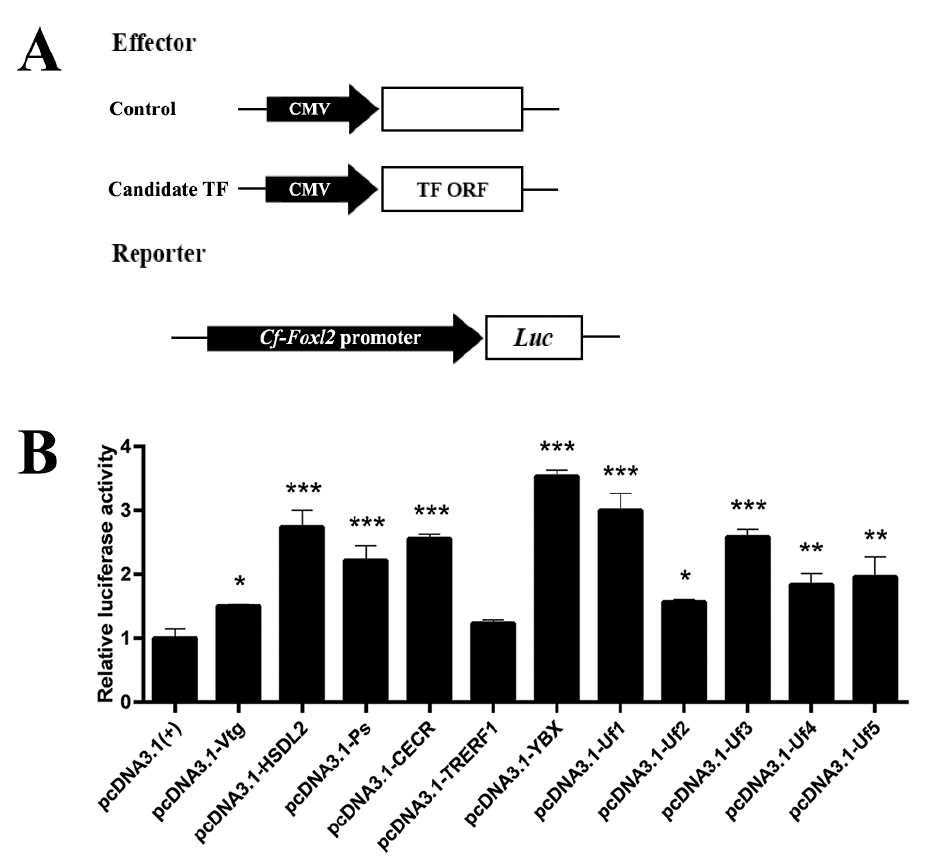
Figure 3. Cf-Foxl2 transcriptional regulation by the candidate factors detected with transient trans- fection. ( A ) Schematic representation of the report vector and effector vector compositions. ( B ) The Cf-Foxl2 transcription regulation in the HEK293T cells transfected transiently with the report and effect vectors. 1: PGL3- Foxl2 - Luc + pcDNA3.1 (+); 2: PGL3- Foxl2 - Luc + pcDNA3.1- Vtg ; 3: PGL3- Foxl2 - Luc + pcDNA3.1- HSDL2 ; 4: PGL3- Foxl2 - Luc + pcDNA3.1- Ps ; 5: PGL3- Foxl2 - Luc + pcDNA3.1- CECR